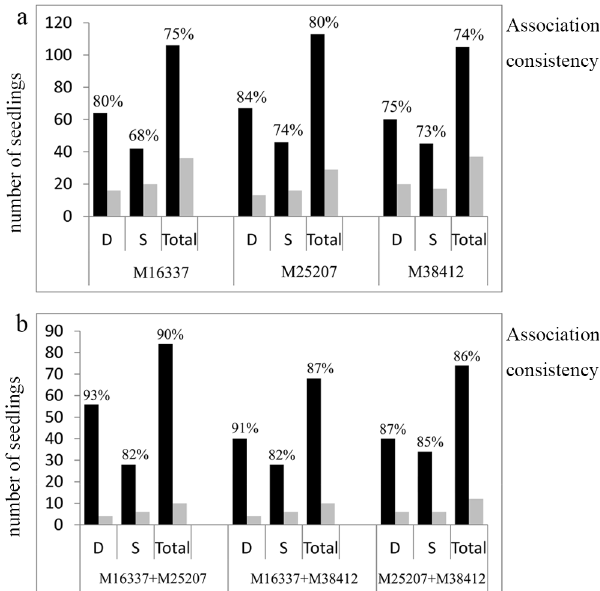
Fig 7. Association consistency between the plant architecture phenotypes and the SNP markers in the F 1 population. The figures immediately above each column are the accuracy rates observed in that genotype-phenotype category. Association consistency is the proportion of seedlings for each plant type phenotype with the expected genotype. The black pillar represents the correct proportion, and the grey pillar represents the wrong proportion in the genotype-phenotype association. (a) Association consistency using a single marker, and (b) association consistency using marker combinations.